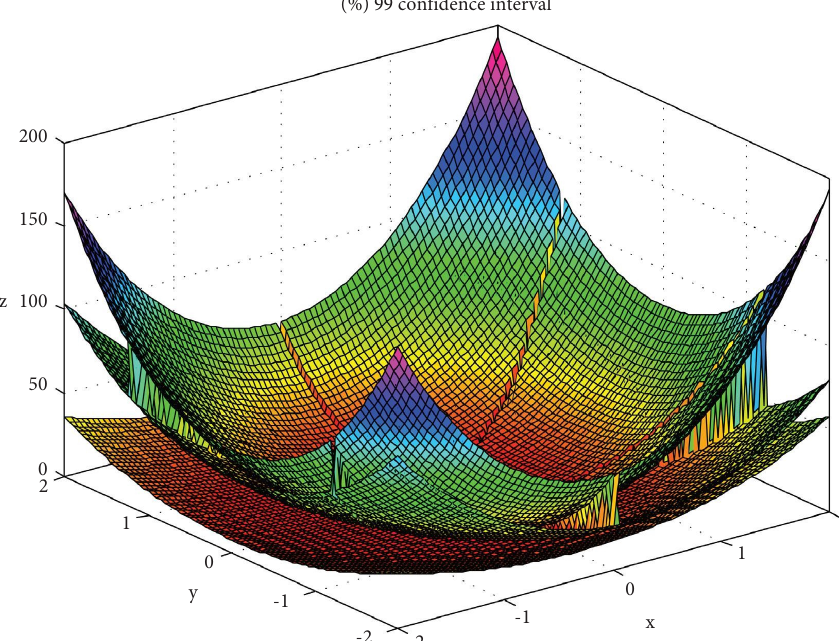
Figure 3: Te 99% confdence interval of equation (17) for α � 1 , β �